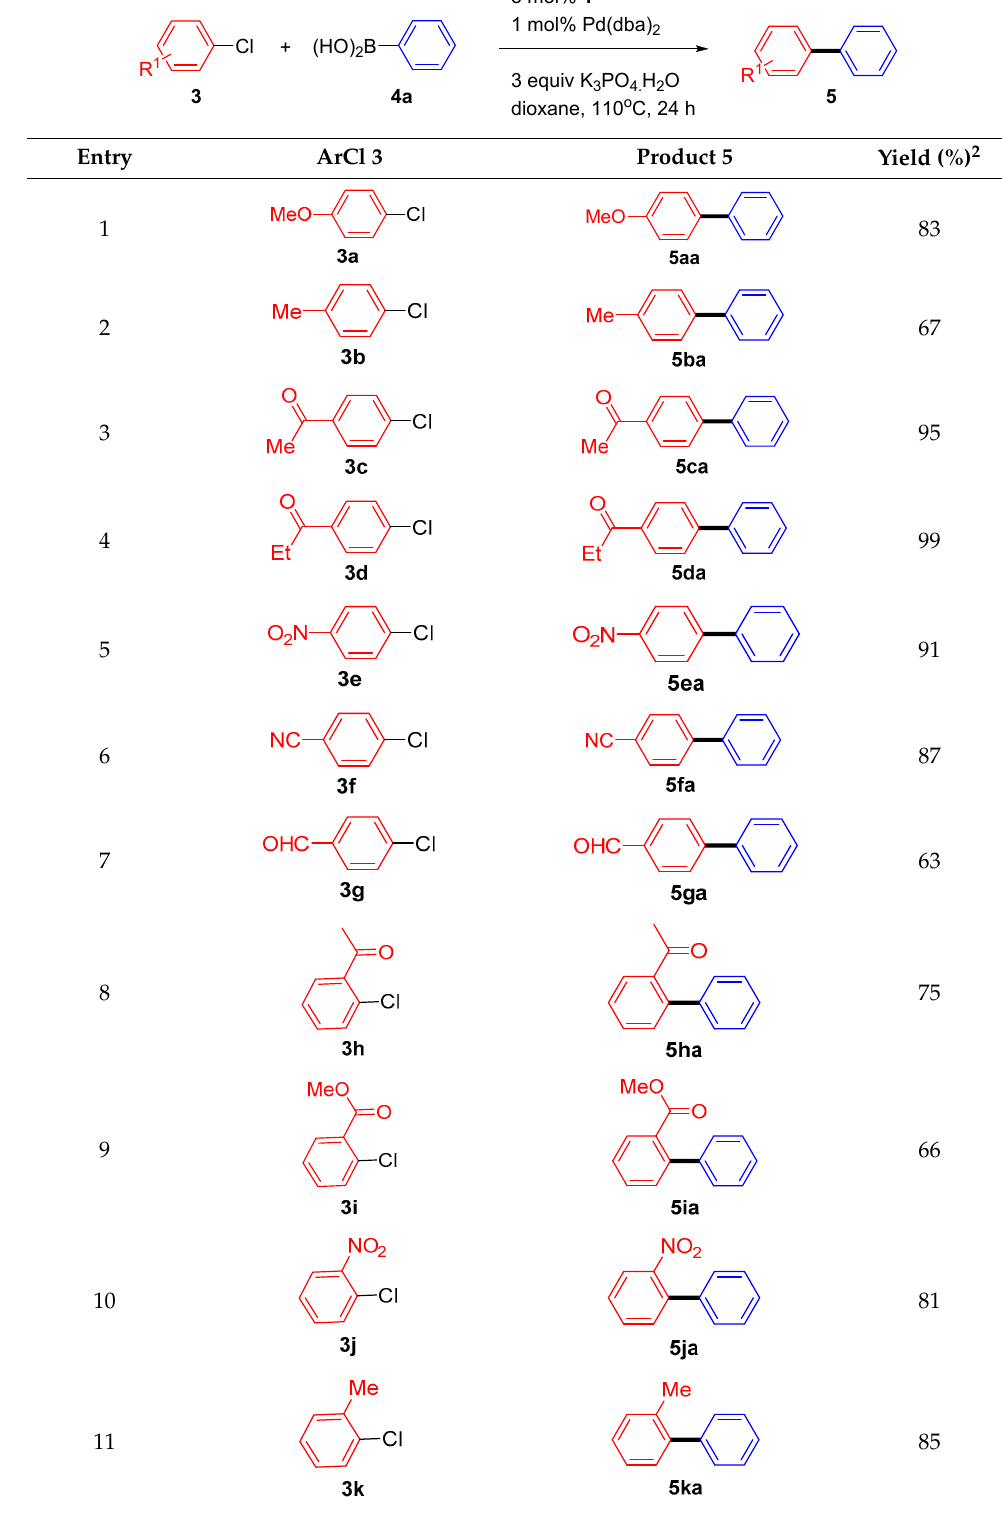
Table 2. In situ-generated catalyst catalyzed Suzuki–Miyaura cross-coupling reaction of aryl chlorides 1 .